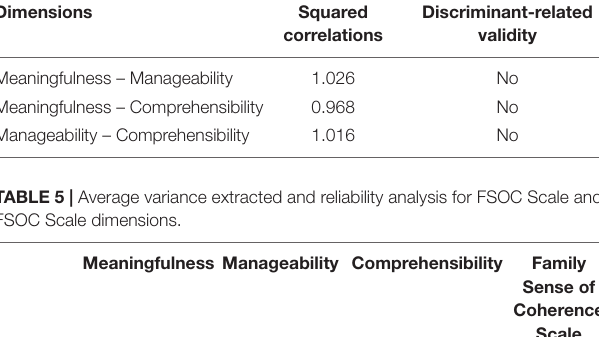
TABLE 4 | Discriminant-related validity of the FSOC Scale. Dimensions